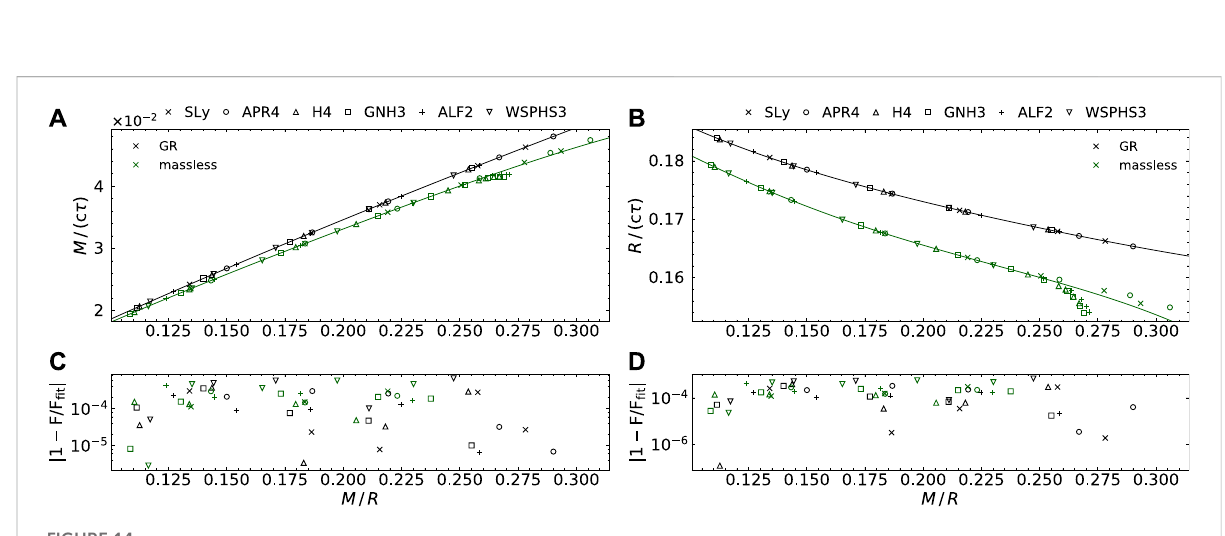
FIGURE 14 Radial ϕ -modeuniversalrelations:dimensionlessinversedampingtime M /( c τ ) versus compactness C = M / R (A) and fi terrors (C) ;dimensionless inverse damping time R /( c τ ) versus compactness C (B) and fi t errors (D) . The symbols indicate the respective equation of state. The massless scalar – tensor case is shown in green, and the general relativistic case is shown in